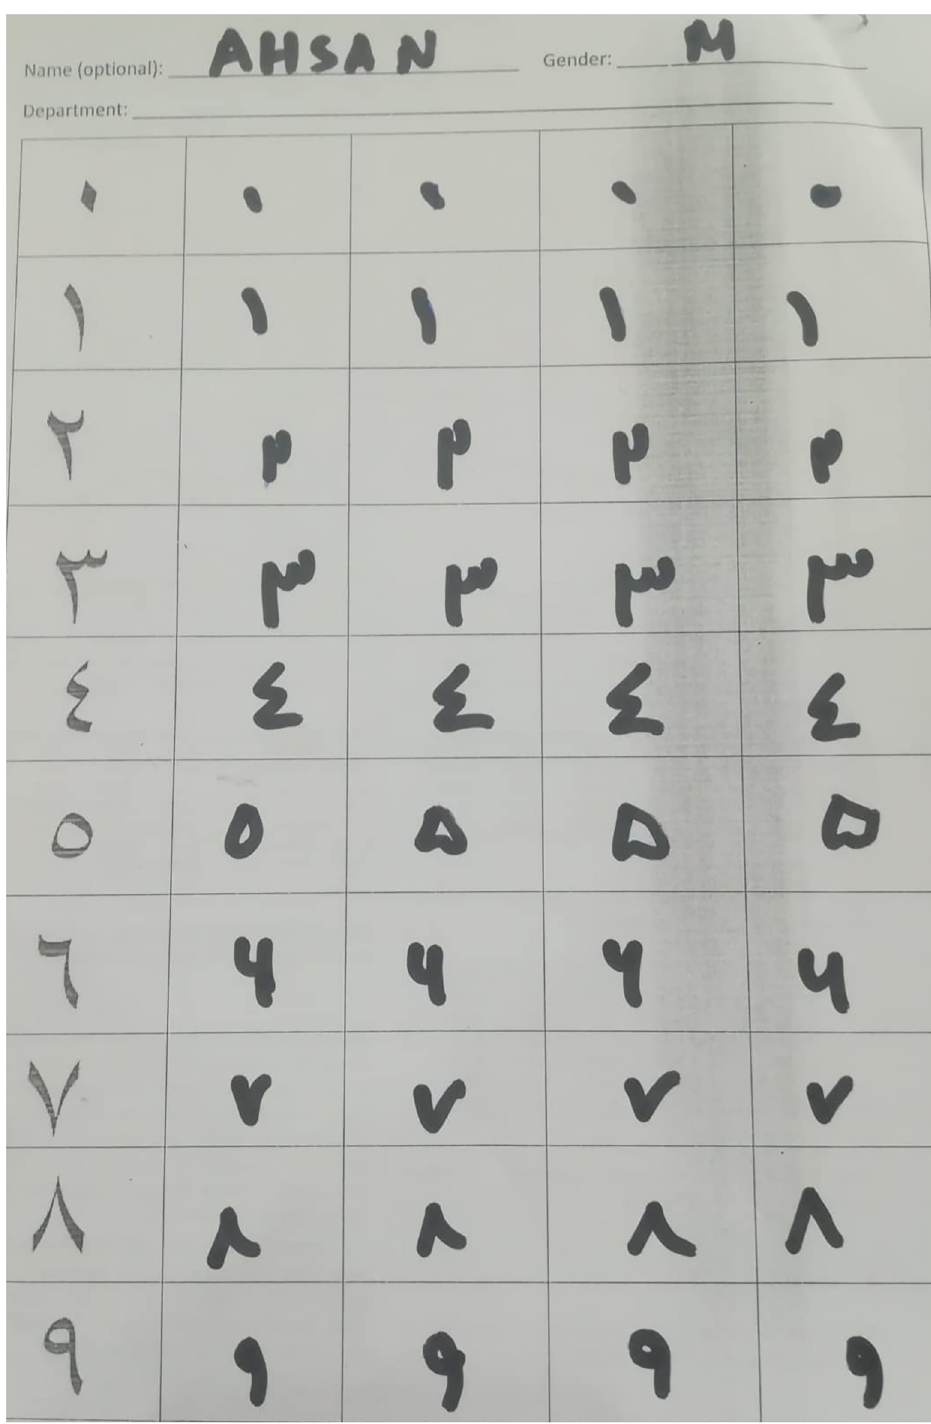
Fig 1. PHND form filled by a participant which was distributed among faculty members and students of three different universities.